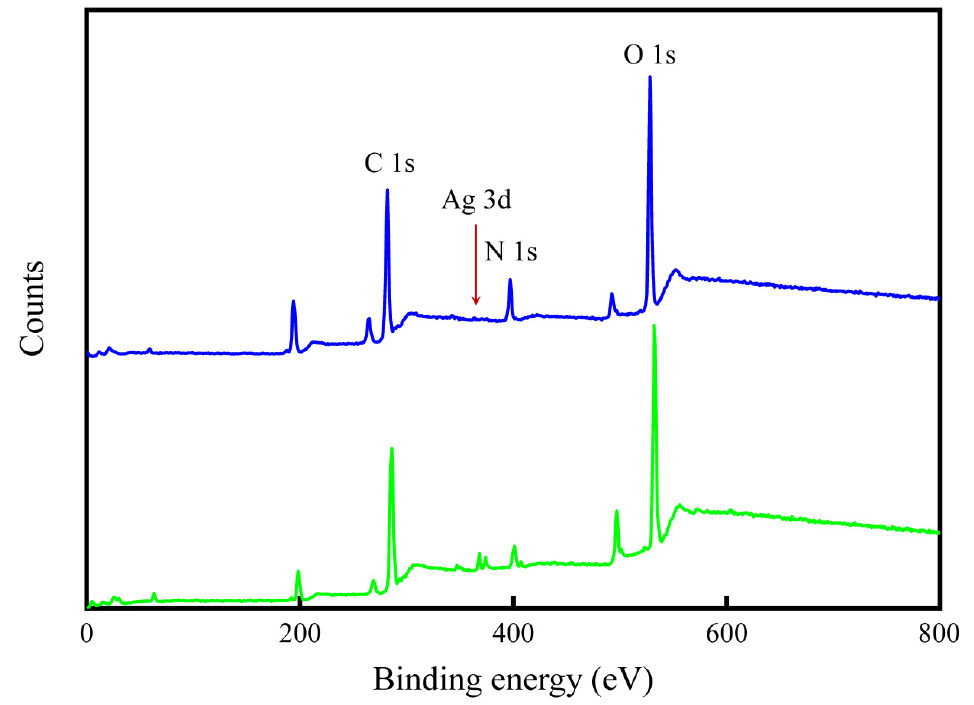
Figure 4. XPS survey spectra of SA-AgNPs (blue line) and SA-AgNPs with 10 ppm dimethoate (green line).